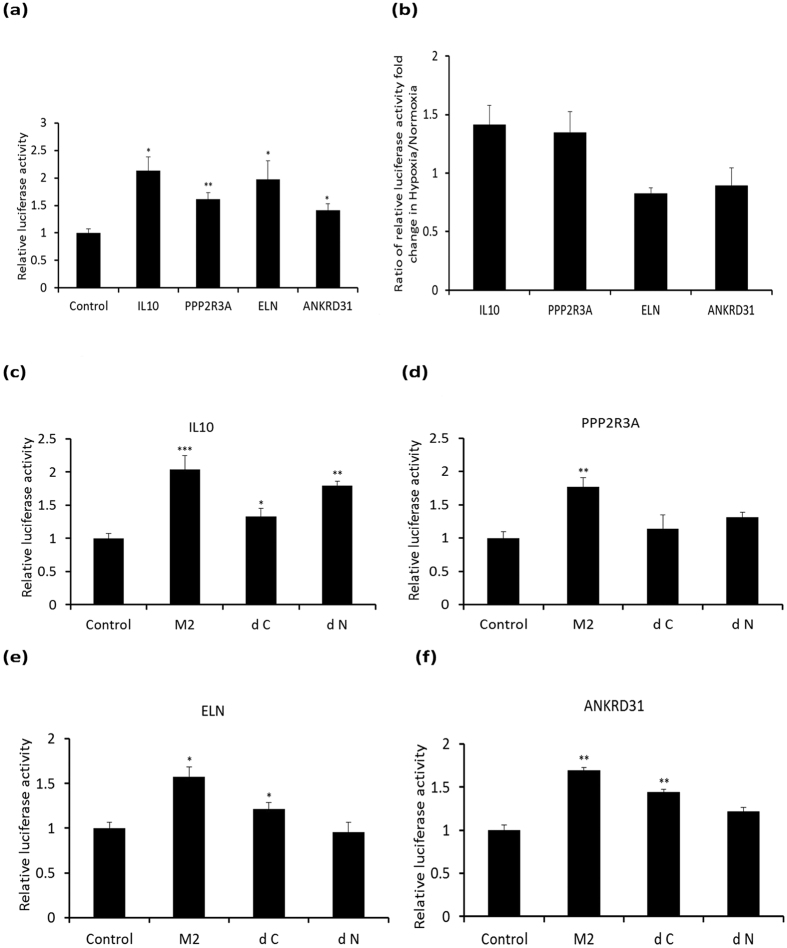
Reporter assay on enriched loci annotated to IL10, PPP2R3A, ELN and ANKRD31.Cypridina luc reporter plasmid loaded with or without sequences of enriched loci annotated to IL10, PPP2R3A, ELN or ANKRD31was used for the assay. Cypridina luciferase activity was normalized to the red firefly luciferase activity. (a) Luciferase activity is presented relative to empty vector in BEAS-2B under normoxia. (b) Relative luciferase activity between hypoxia (treated with 150 μM CoCl2) and normoxia. (c–f) Relative luciferase activity when the reporter plasmid was co-transfected with HIF-2α variants in HEK293 in a separate expression plasmid from Addgene. M2, a stabilized full length HIF-2α mutant, dN or dC, the N-TAD or the C-TAD truncated HIF-2α respectively. Data are shown as mean ± SD, n = 3. *P < 0.05; **P < 0.01 and ***P < 0.001 vs. control.